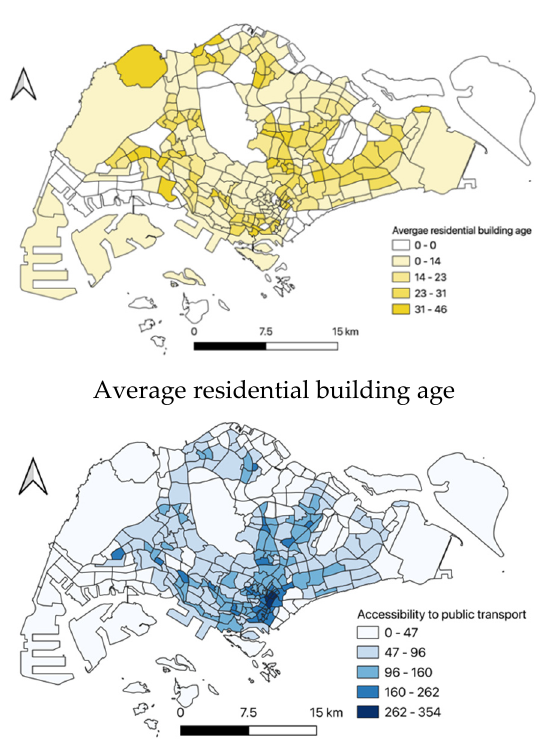
Figure 2. Parcel deliveries demand per household over three months.